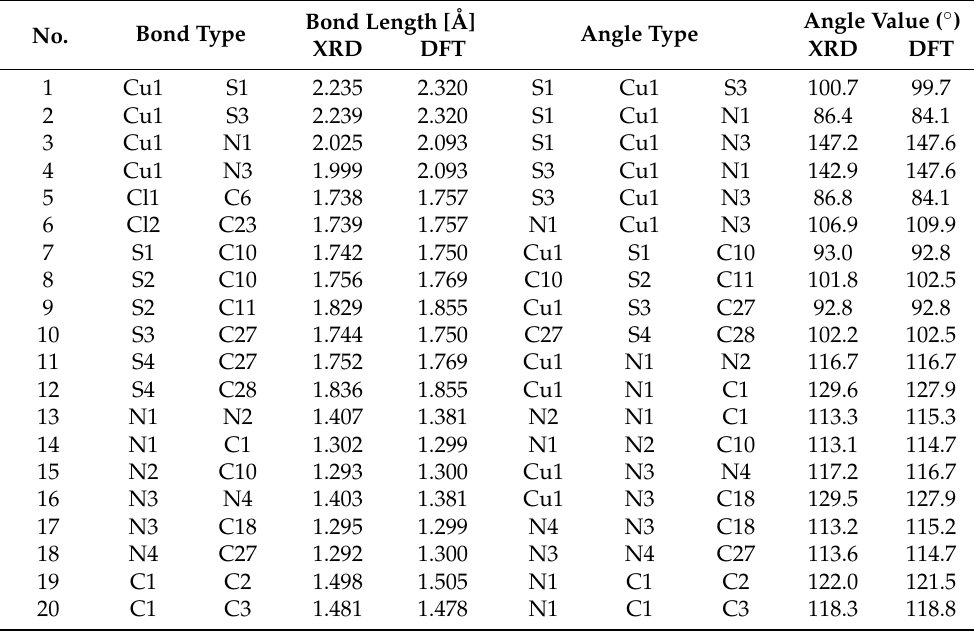
Figure 5. XRD/density functional theory (DFT) histogram of bond lengths ( a ), XRD/DFT graphical correlation for bond lengths ( b ), DFT/XRD angles histogram ( c ), and XRD/DFT graphical correlation for angles ( d ). Table 2. Designated XRD/DFT bond lengths and